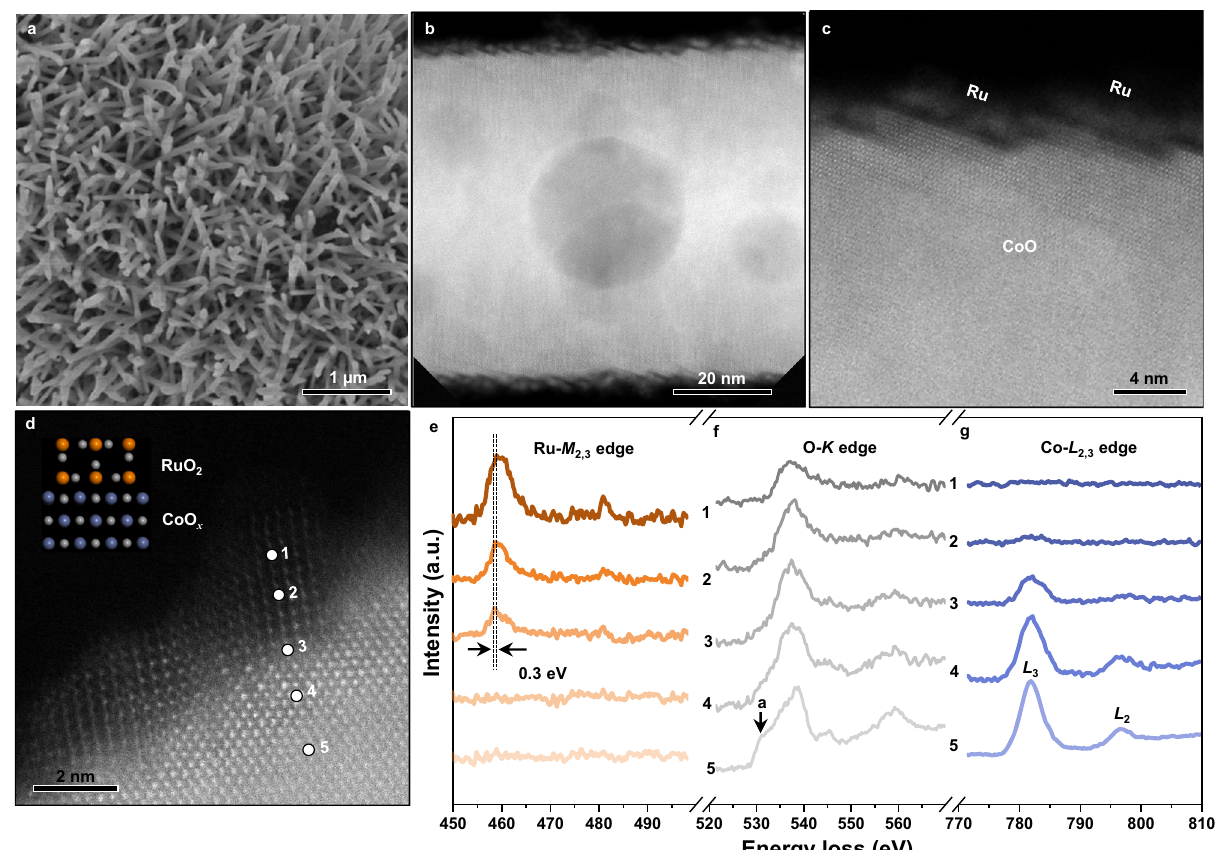
Fig. 2|SynthesisofRuO2/CoO x hybridcatalyst.a Low-magni fi cation SEMimage of Ru/CoO. b , c Low- and high-magni fi cation HADDF-STEM images of Ru/CoO, respectively. d , Atomic resolution HADDF-STEM image of RuO 2 /CoO x , with the